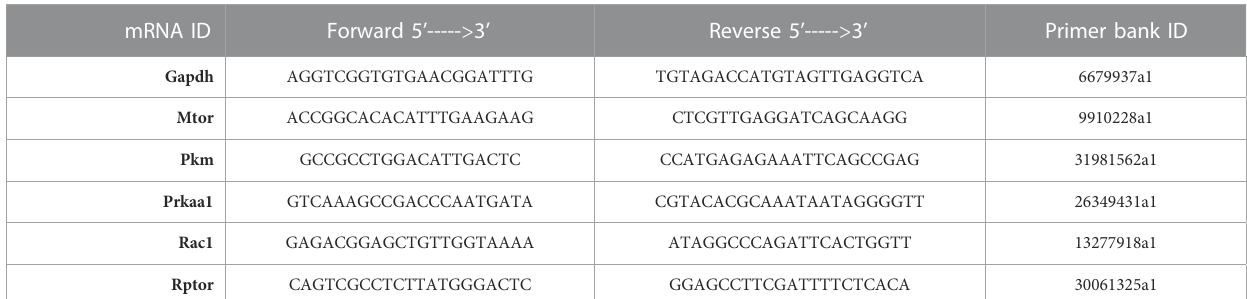
TABLE 1 Used primers with their Primer Bank identi fi cation